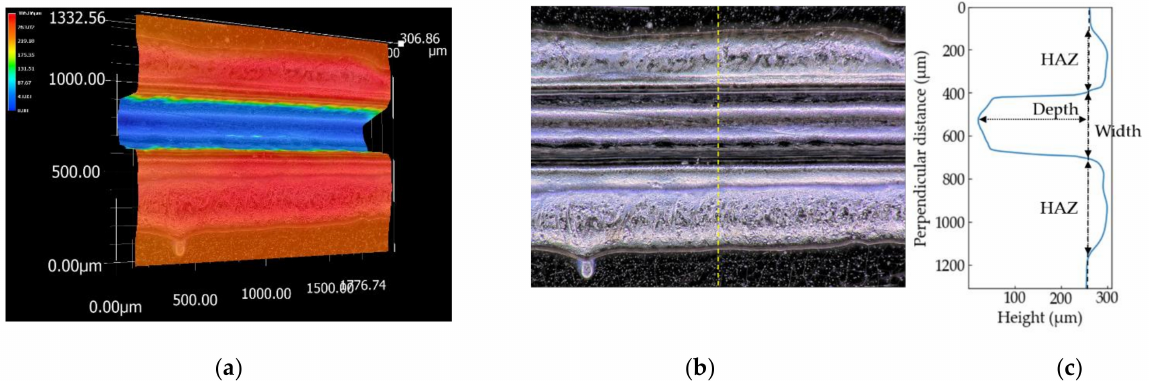
Figure 4. Three-dimensional shape ( a ), optical image ( b ) and the height profile at the yellow dash line ( c ) of the PP sample measured by the digital microscope. The sample is processed at S = 100 mm/s.